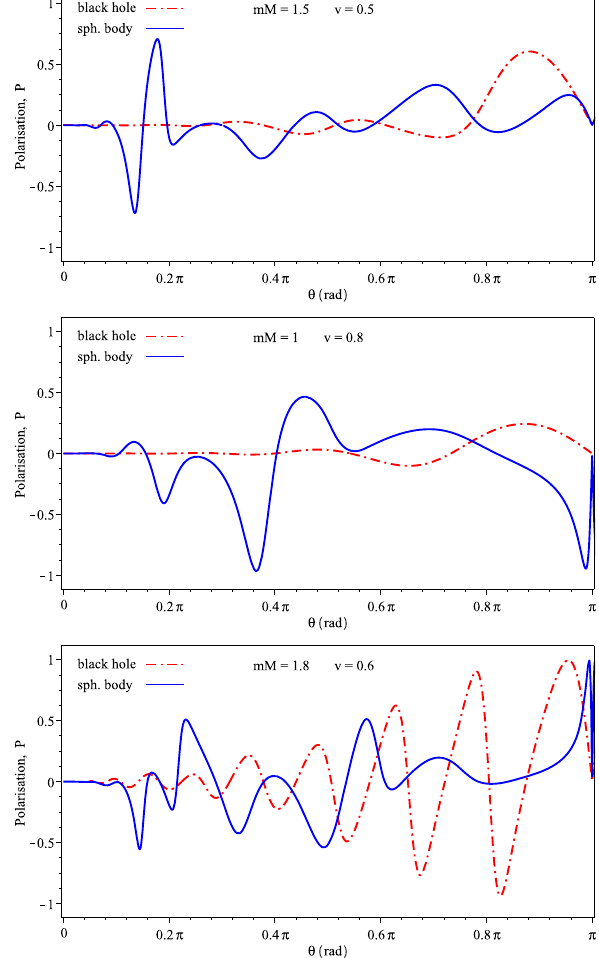
Fig. 3 Polarization as a function of the scattering angel θ . Comparison with the black hole polarization. We observe that the pattern of polar- ization for the massive spherical body is much more complex (solid blue